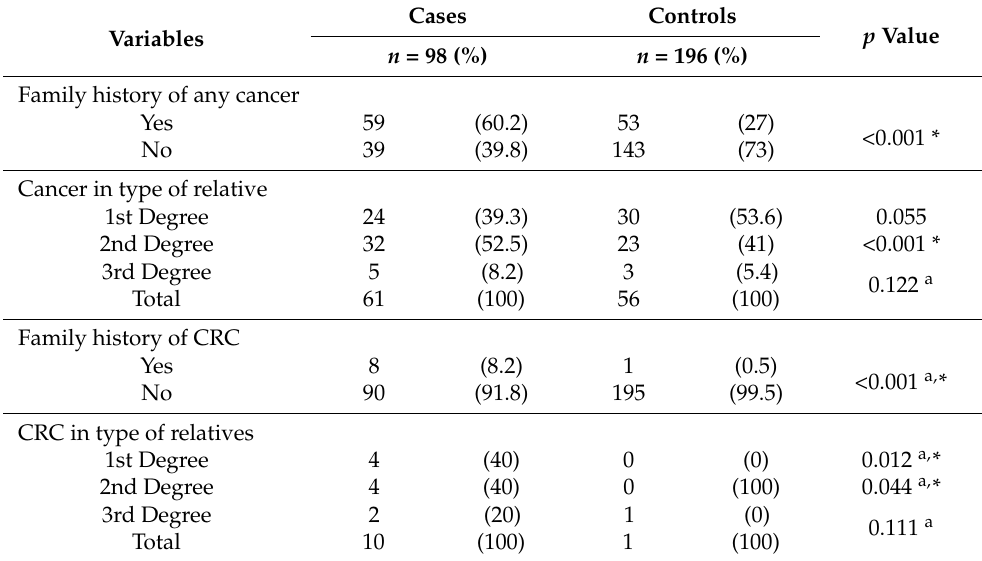
Table 2. Family history of any type of cancer and colorectal cancer.